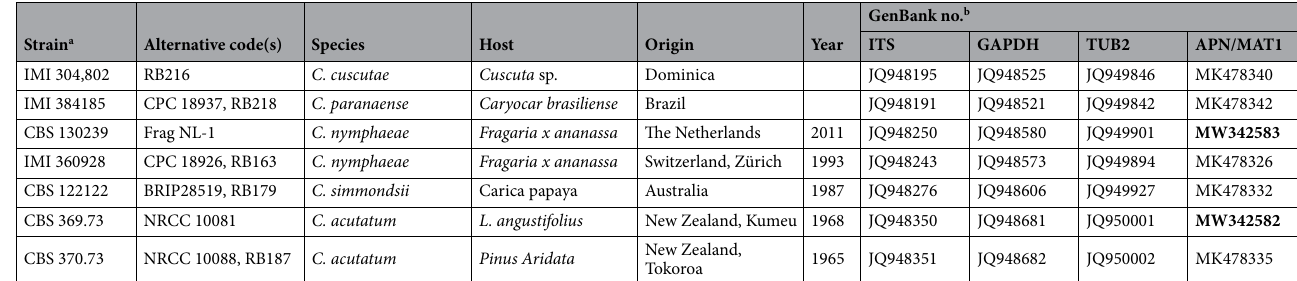
Table 1. Isolation details and GenBank accessions of Colletotrichum strains used in this study. JA strains from the FiBL culture collection characterized in this study, RB personal collection of Riccardo Baroncelli